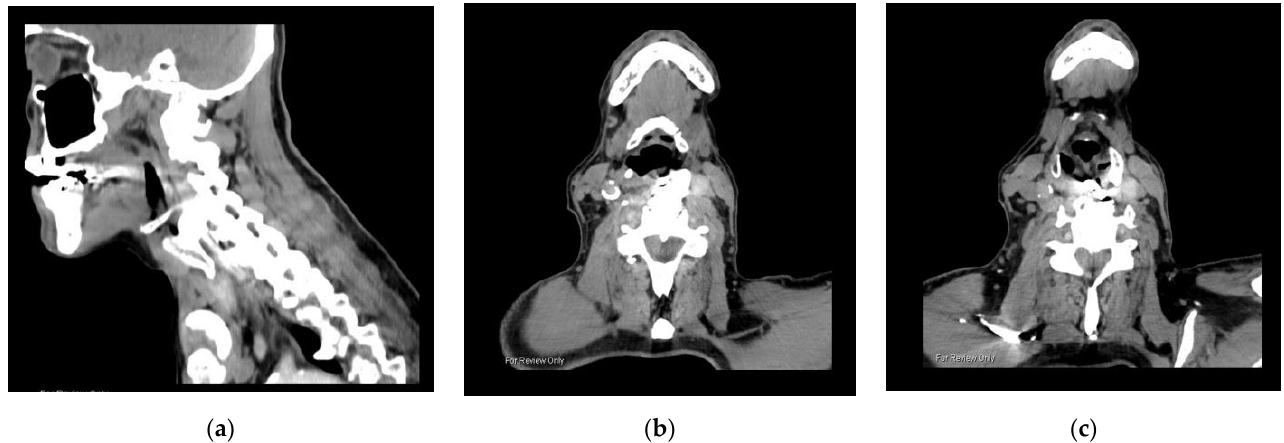
Figure 3. CT images show a large bony overgrowth fusing the larynx to anterior cervical spine: ( a ) sagittal view; ( b ) axial view of upper border at C3 level; ( c ) lower border of bony overgrowth at C6 level. Figure created by author.